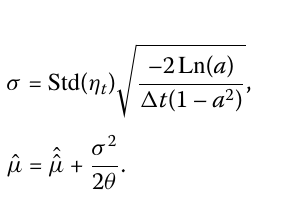
Table 5 Parameters of the exponential Ornstein–Uhlenbeck process obtained for the gold spot price through the least squares method Miu hat Theta Sigma Daily 7.22 0.0002